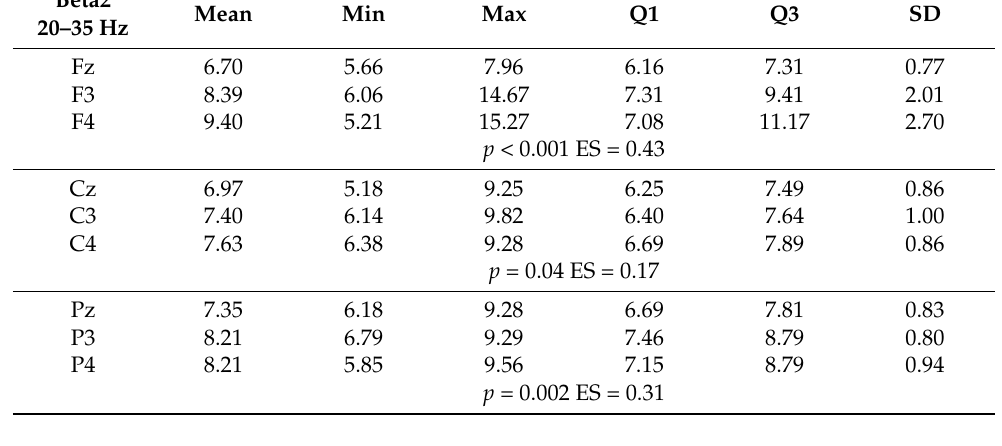
Table 7. Descriptive statistics for Beta2 waves across all channels ( µ V).